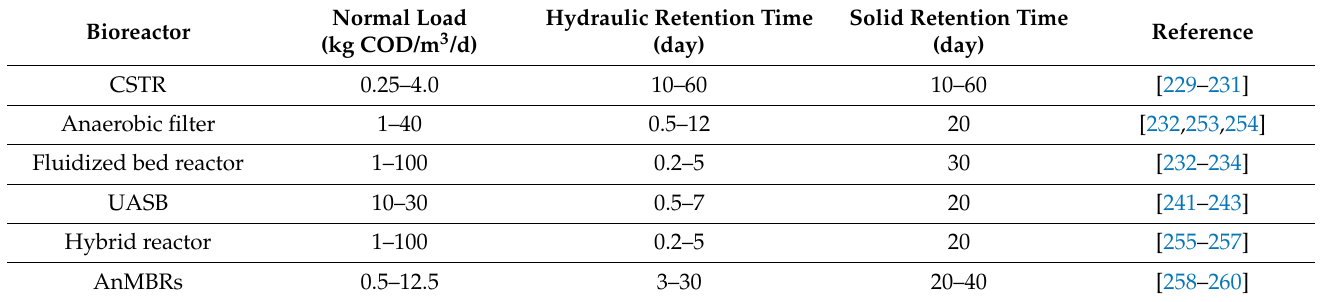
Table 8. Wastewater treatment parameters across different types of digestion